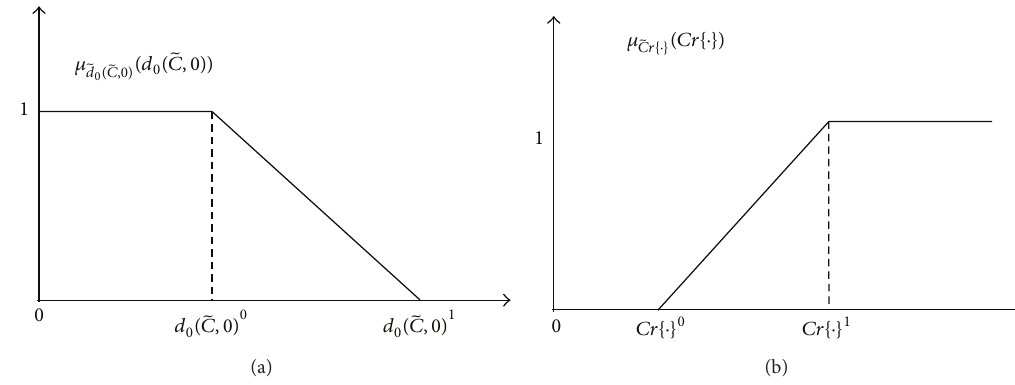
Figure 2: Membership functions for fuzzy total cost and credibility